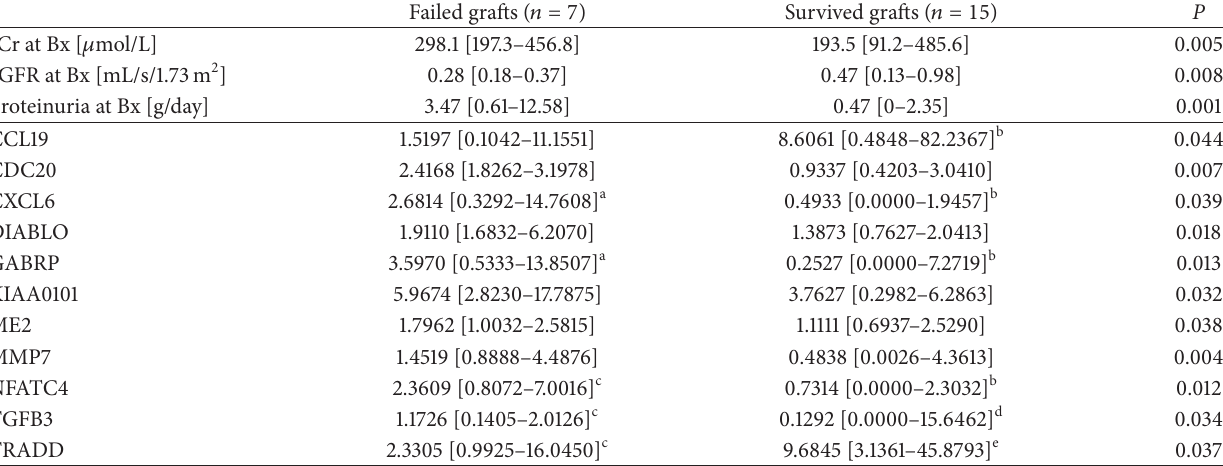
Table 2: Significant differences between failed and survived grafts after chronic rejection (both CAMR and CTCMR). Only variables that reach statistical significance are listed.